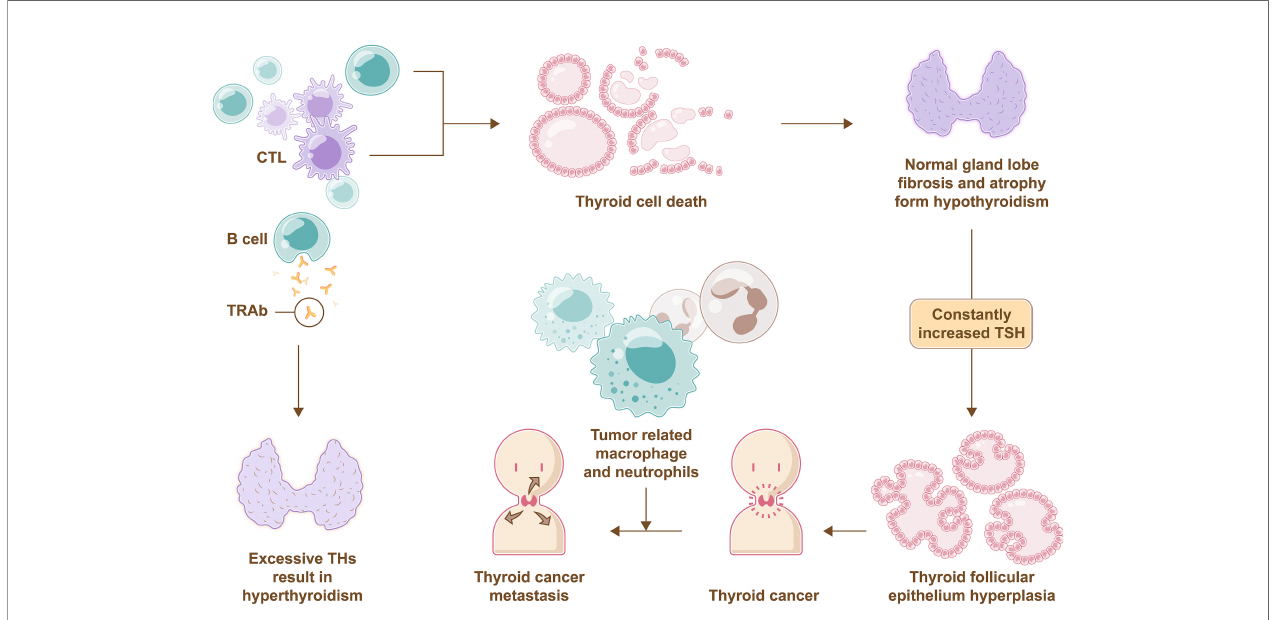
FIGURE 5 | Immune imbalance in thyroid disease. Normal thyroid cells die due to attacks of B cells and CTL, and gland lobes undergo fi brosis and atrophy, which subsequently leads to hypothyroidism that promotes TSH secretion through negative feedback, then excessive TSH lead to pathological hyperplasia of thyroid folicullar epithelium followed by inducing thyroid cancer. Muchmore, tumor-related macrophages and neutrophils in patients with thyroid cancer can promote invasion and metastases of tumor cells. Furthermore, thyrotropin receptor antibodies (TRAb) produced by B cells stimulate TH production and result in